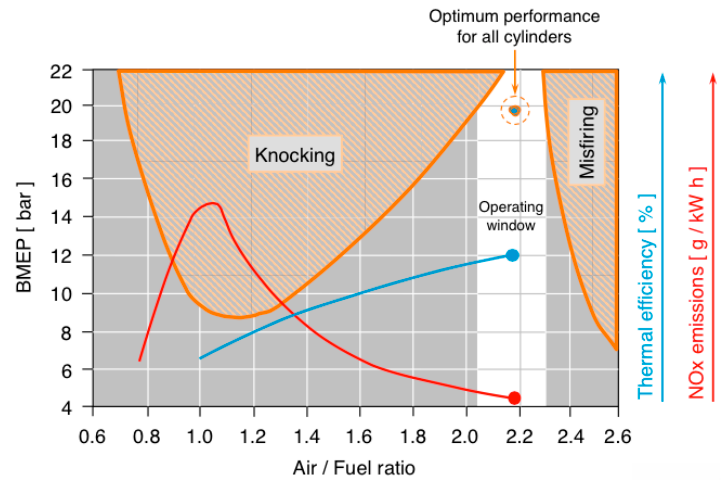
Figure 4. Operation window of Wärtsilä 9L50DF.